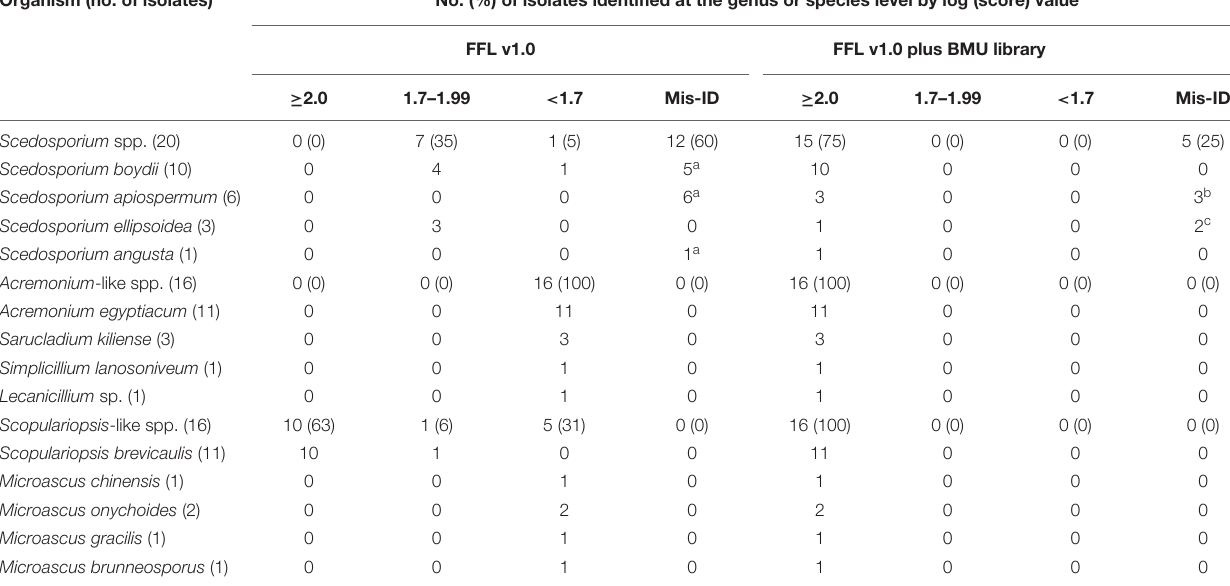
TABLE 2 | Identification of 52 clinical isolates by the Bruker library and the Bruker library plus BMU database. Organism (no. of isolates) No. (%) of isolates identified at the genus or species level by log (score) value